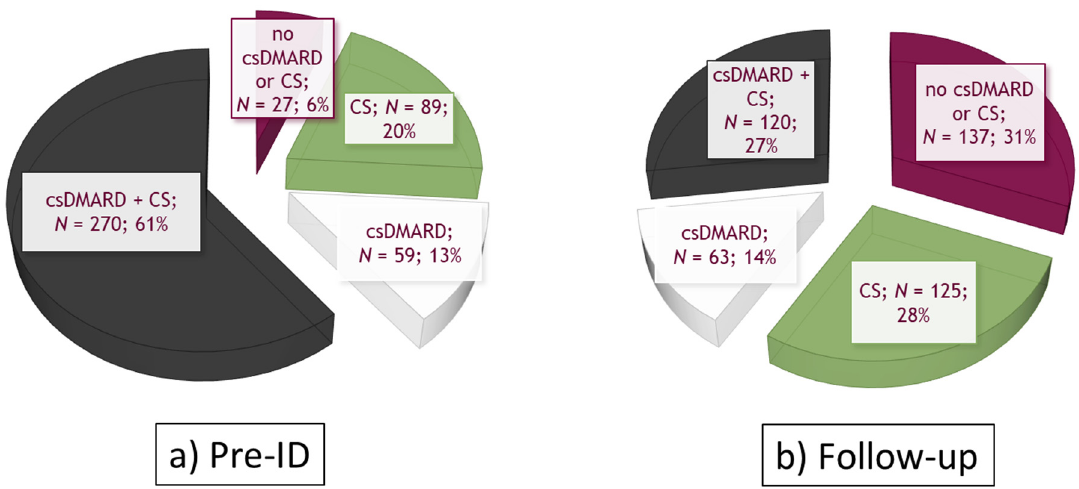
Figure 2. Treatment patterns in baricitinib cohort ( N = 445) ( a ) in the 12 months before ID (pre-ID); ( b ) during follow-up. Abbreviations: csDMARDs, conventional synthetic disease-modifying antirheumatic drugs; CS, corticosteroids.